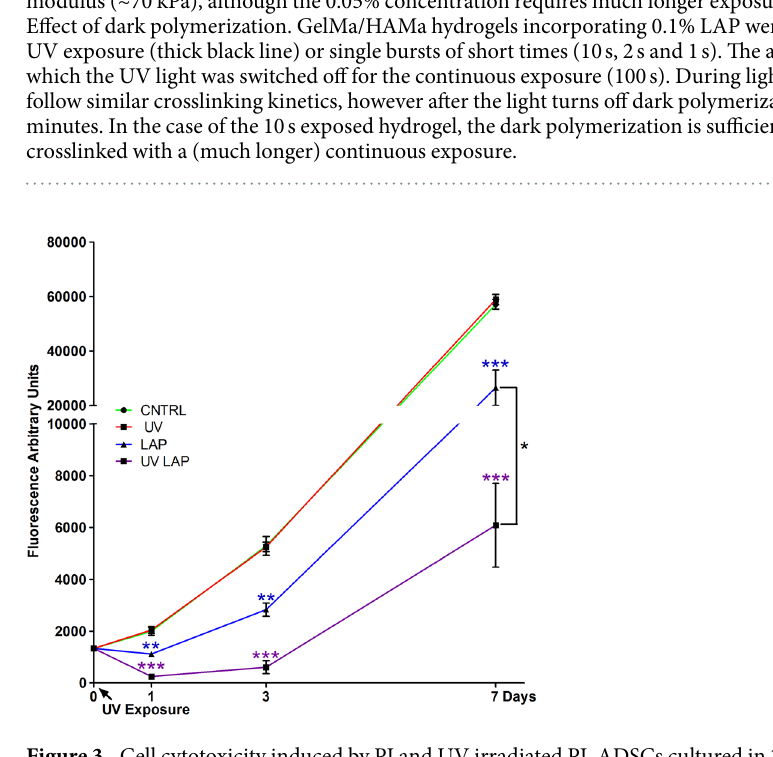
Figure 3. Cell cytotoxicity induced by PI and UV irradiated PI. ADSCs cultured in 2D and assayed along 7 days in culture with a metabolic test (Cell Titer-Blue ® ) to measure the cytotoxicity induced by cell exposure to UV light alone (UV), LAP on its own (LAP) and UV exposed LAP (LAP-UV) compared to untreated cells (CNTRL). Error bars represent standard error of the mean between three replicates. The calculated statistical significance was obtained by unpaired t test and calculated versus CNTRL. At day 7 statistics is calculated also for LAP-UV versus